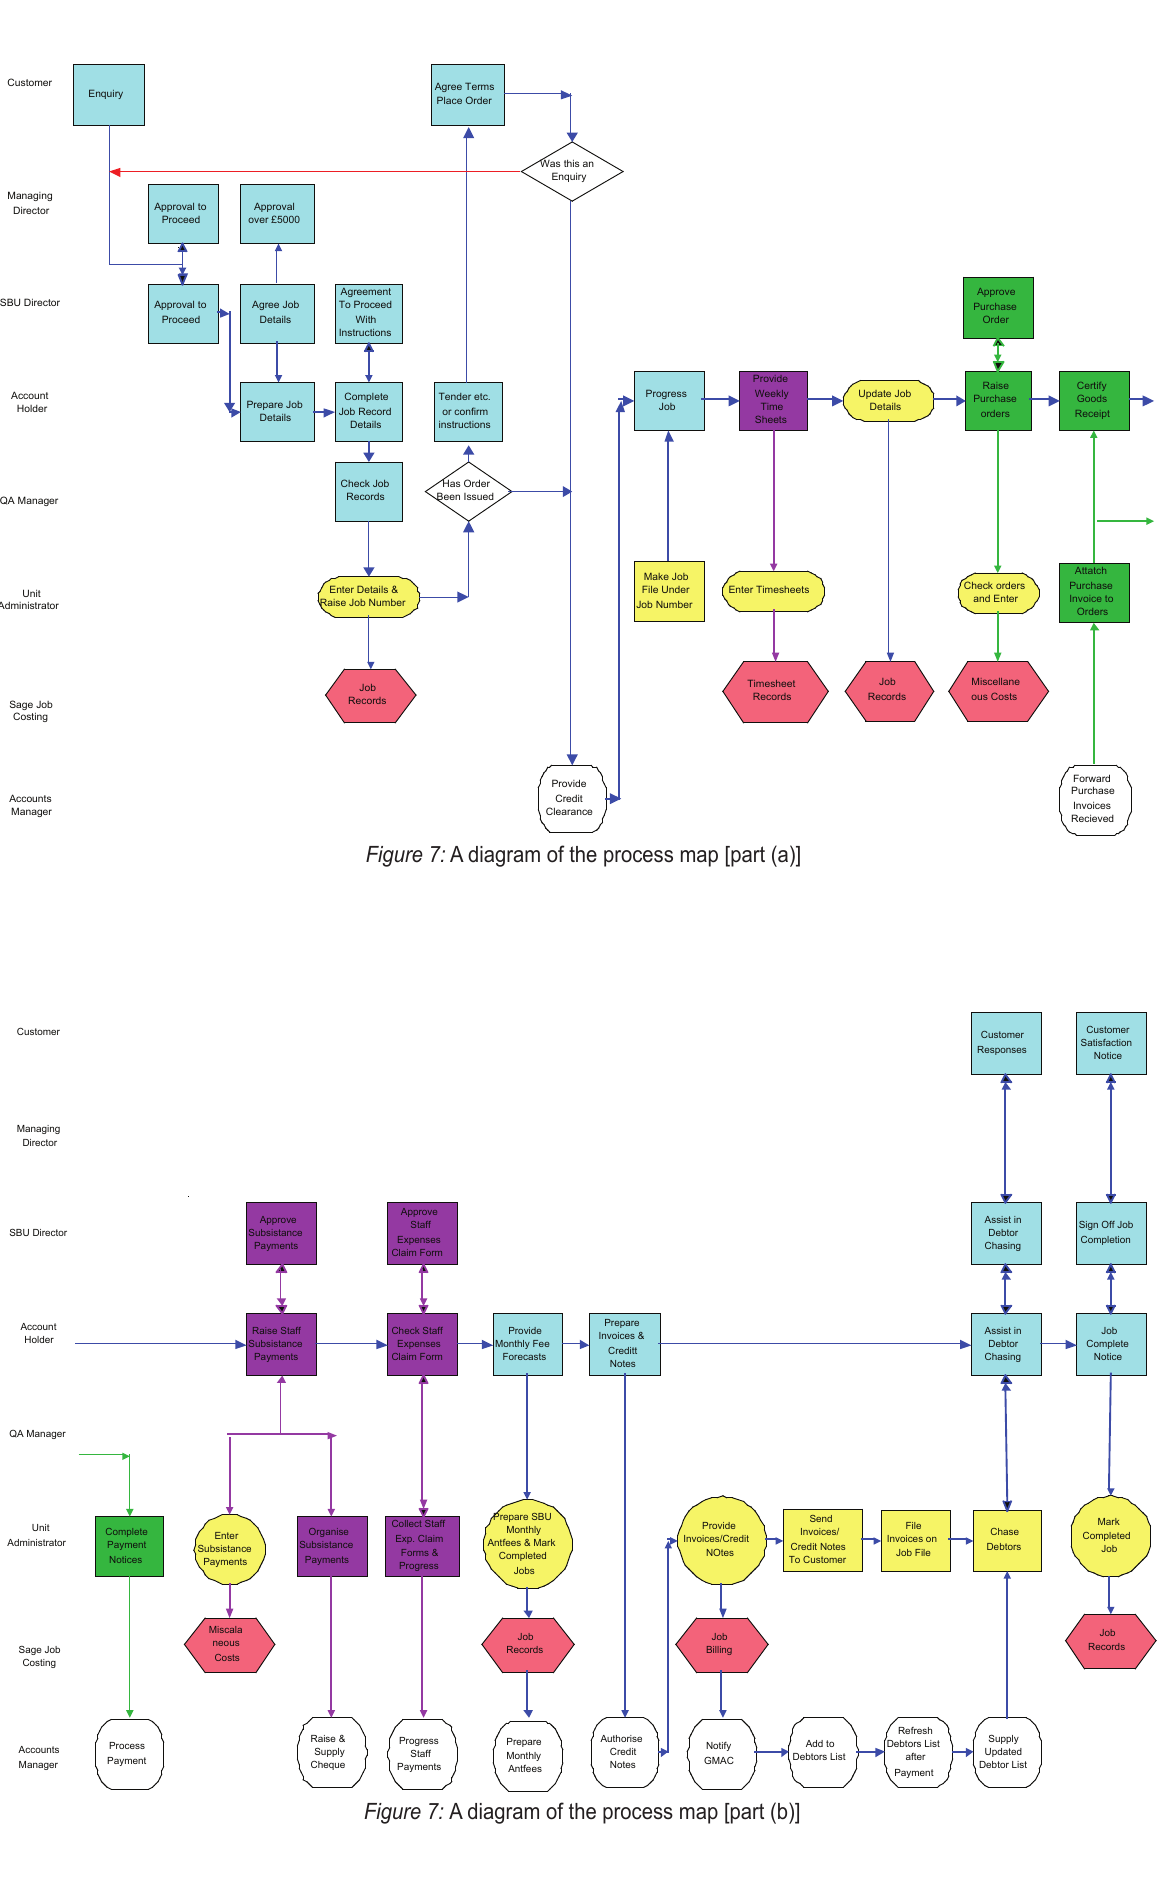
Figure 7: A diagram of the process map [part